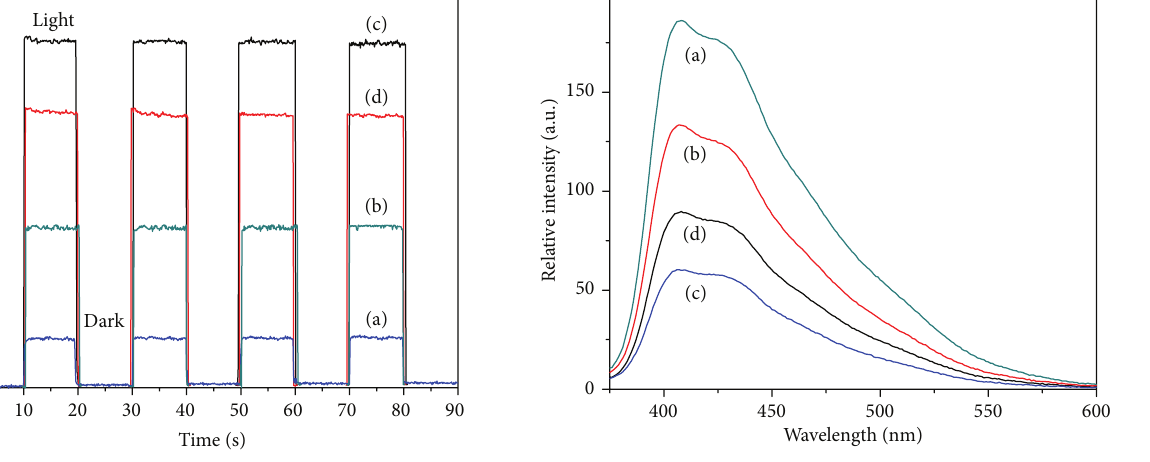
Figure 8: Photocurrent response of the as-prepared samples under visible light illumination: (a) carbon nitride; (b) CdS/CN-5; (c) CdS/CN-10; (d) CdS/CN-30.